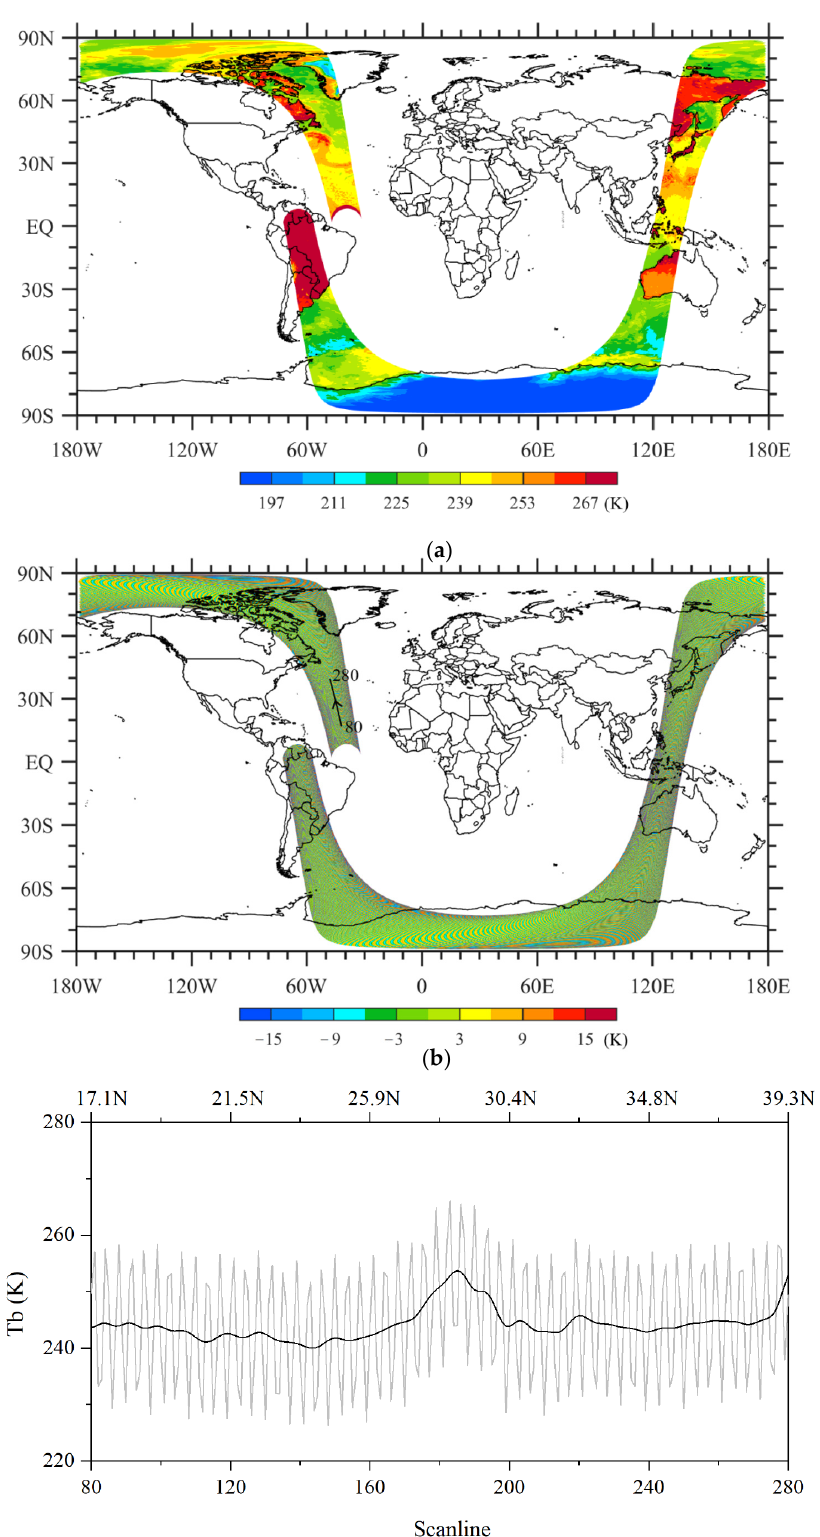
Figure 7. ( a ) Same as Figure 3a except for having removed ( b ) the across-track high-frequency noise. ( c ) Along-track variations of channel-1 TB observations at the 30th FOV before (grey line) and after (black line) removing the high-frequency